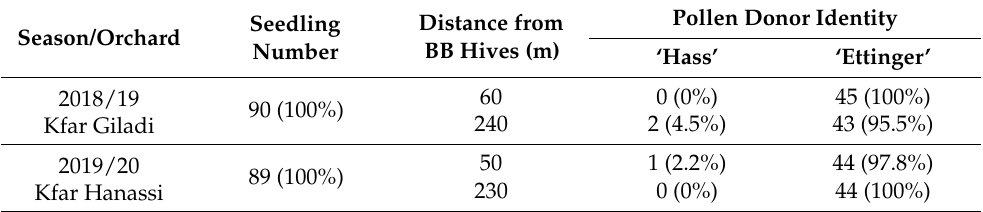
Table 7. Paternity analysis of ‘Hass’ fruit sampled from trees at different distances from the bumblebee (BB)